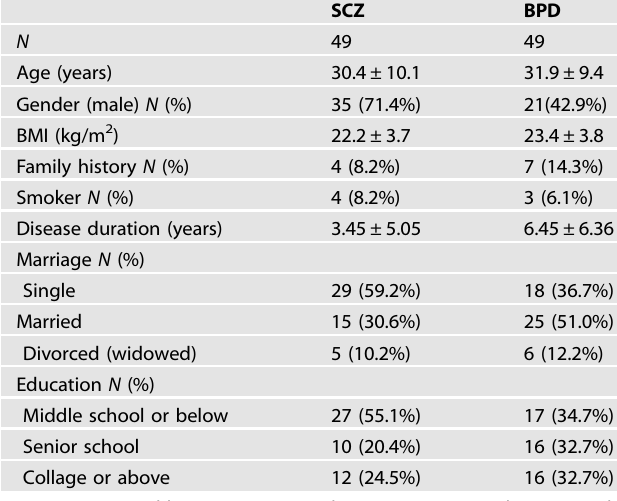
Table 1. Demographic characteristics of SCZ and BPD samples.